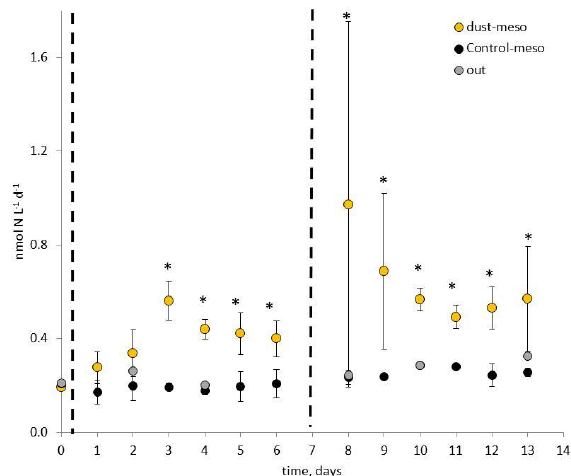
Fig. 3. Mean N 2 fixation rate ( n = 3) in nmolNL − 1 d − 1 during the DUNE-2-R1 and -R2 experiments in the Control-meso (black dot), Dust-meso (orange dot) and Out (grey dot) at 5m depth. The dotted line represents the time of the dust seeding. Data in the Control- and Dust-meso represent the average and standard deviation of the three replicate mesocosms. Means in the Dust-meso that were signifi- cantly different ( p <0.05) from the Control-meso are labeled with the *